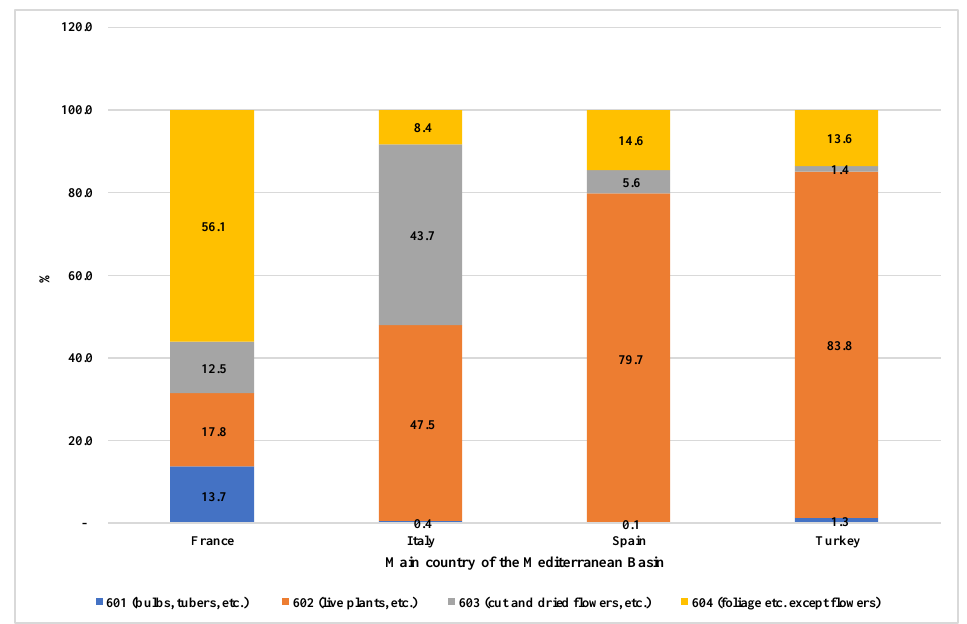
Figure 4. Percent of imports into Mediterranean countries of plant materials for non-food use (UN Comtrade code 06) by subcode in 2018.